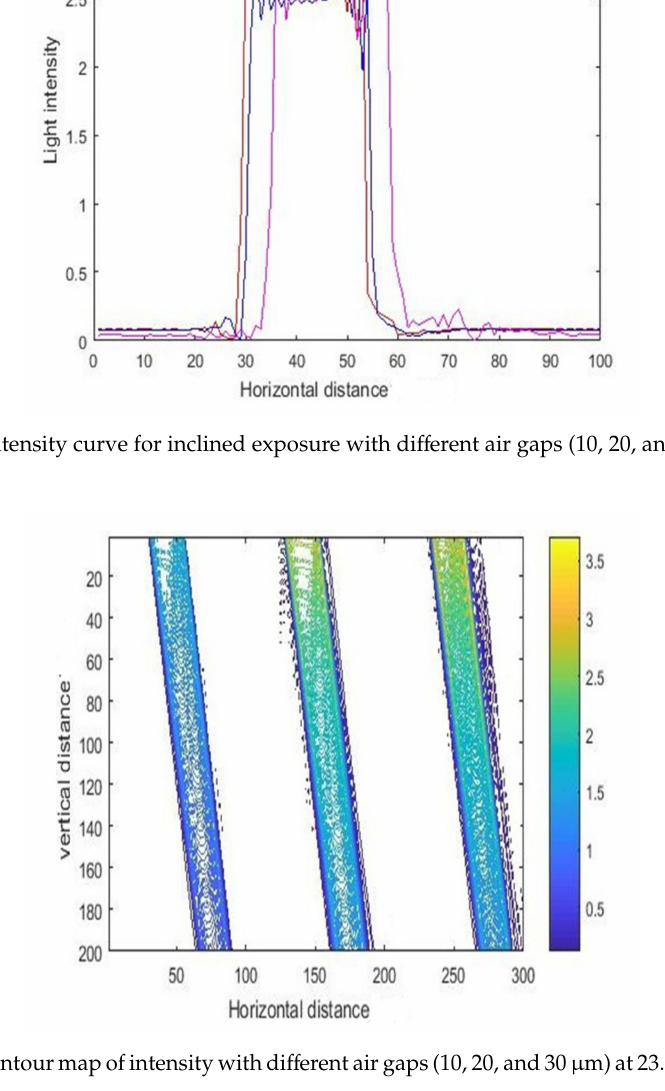
Figure 12. The contour map of intensity with di ff erent air gaps (10, 20, and 30 µ m) at 23.5 ◦ incident